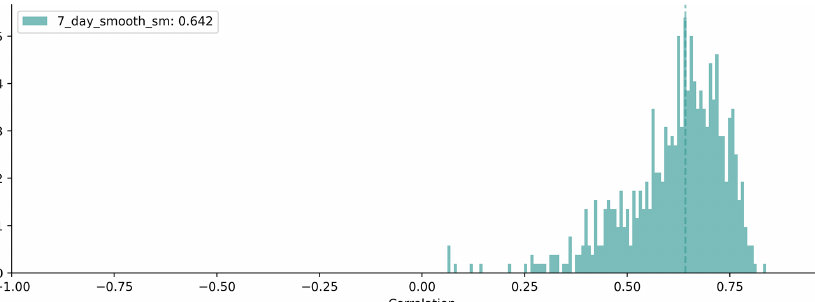
Figure B1. Histogram of catchment correlation scores for the probe-simulated soil moisture and the 7d smoothed ESA CCI Soil Moisture. The median score is 0.64.